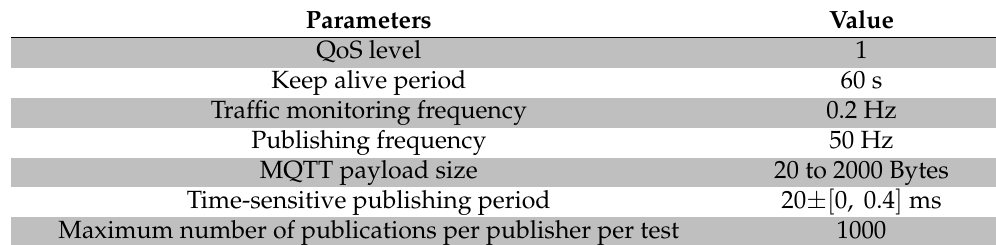
Table 2. Emulation set-up parameters